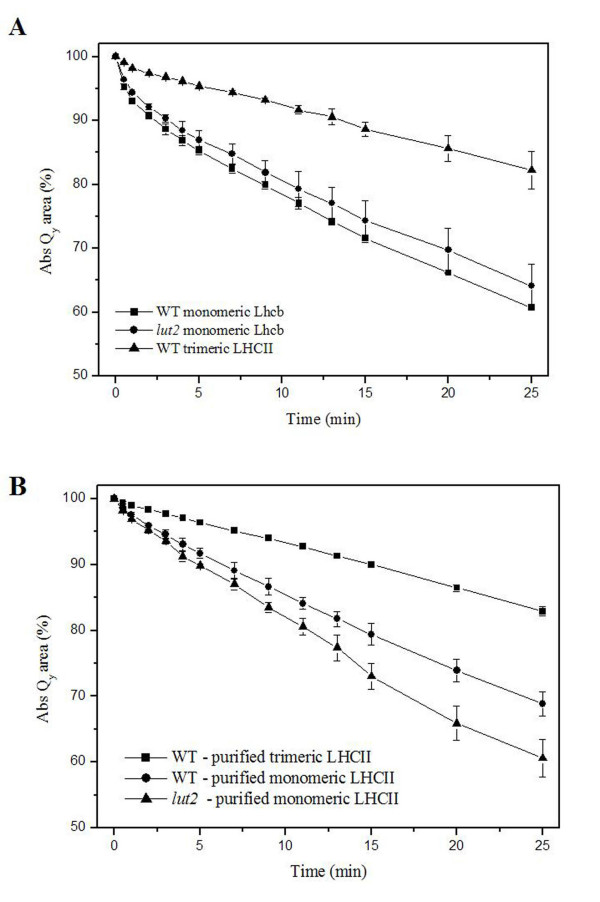
Photobleaching behaviour of isolated Lhcb. (A) Monomeric Lhcb isolated from solubilized thylakoids of WT and lut2.1, and trimeric LHCII from WT were analyzed by following the Qy-transition absorbance decay during strong illumination. (B) Sucrose bands 2 and 3 from WT and lut2.1 were fractionated by flat bed IEF in order to purify LHCII subunits in their monomeric and trimeric form. Kinetics of Qy-transition absorbance decay were measured on isolated complexes as described in Experimental Procedures. Chlorophyll concentrations of Lhcb were set to 8 μg/ml. Samples were cooled to 10°C during measurements.